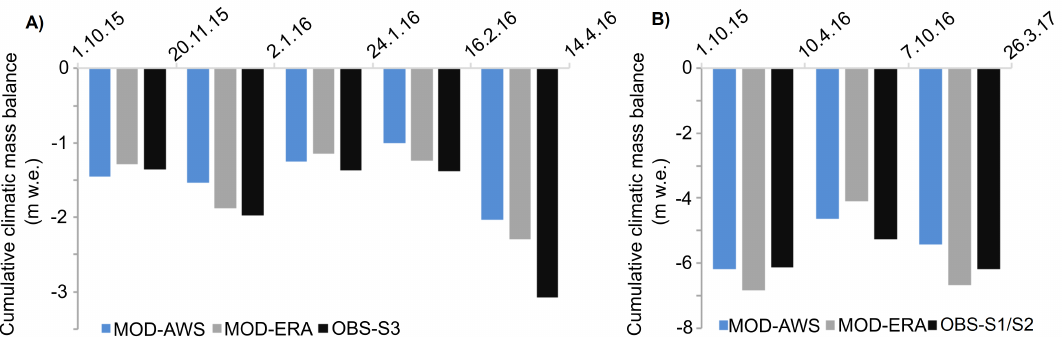
Figure 4. Comparison of modeled (automatic weather stations (AWS) and ERA) and observed climatic mass balance at Schiaparelli Glacier by means of ( A ) ablation stake S3 and ( B ) ablation stakes S1 and S2 as mean values (Figure